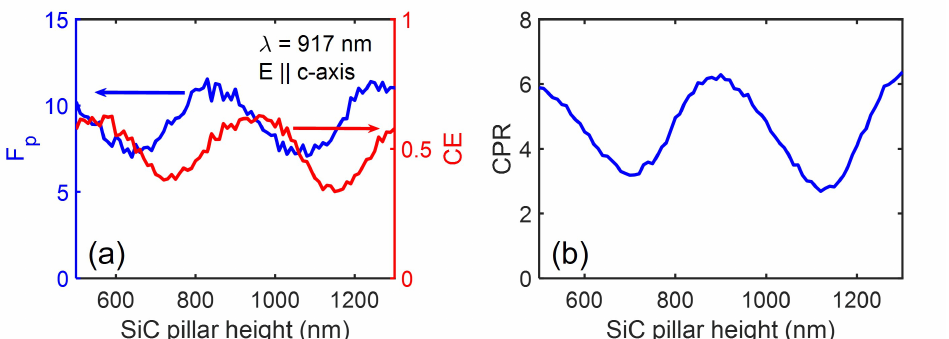
Figure 5. ( a ) The modified Purcell factor, F p and collection efficiency, CE; ( b ) the corresponding CPR performance as a function of the SiC pillar’s height variation for an embedded point defect emitters in SiC pillar emitting at 917 nm. The specified color centres dipole is located 20 nm below the Ag cylinder surface with polarisation along the c-axis.